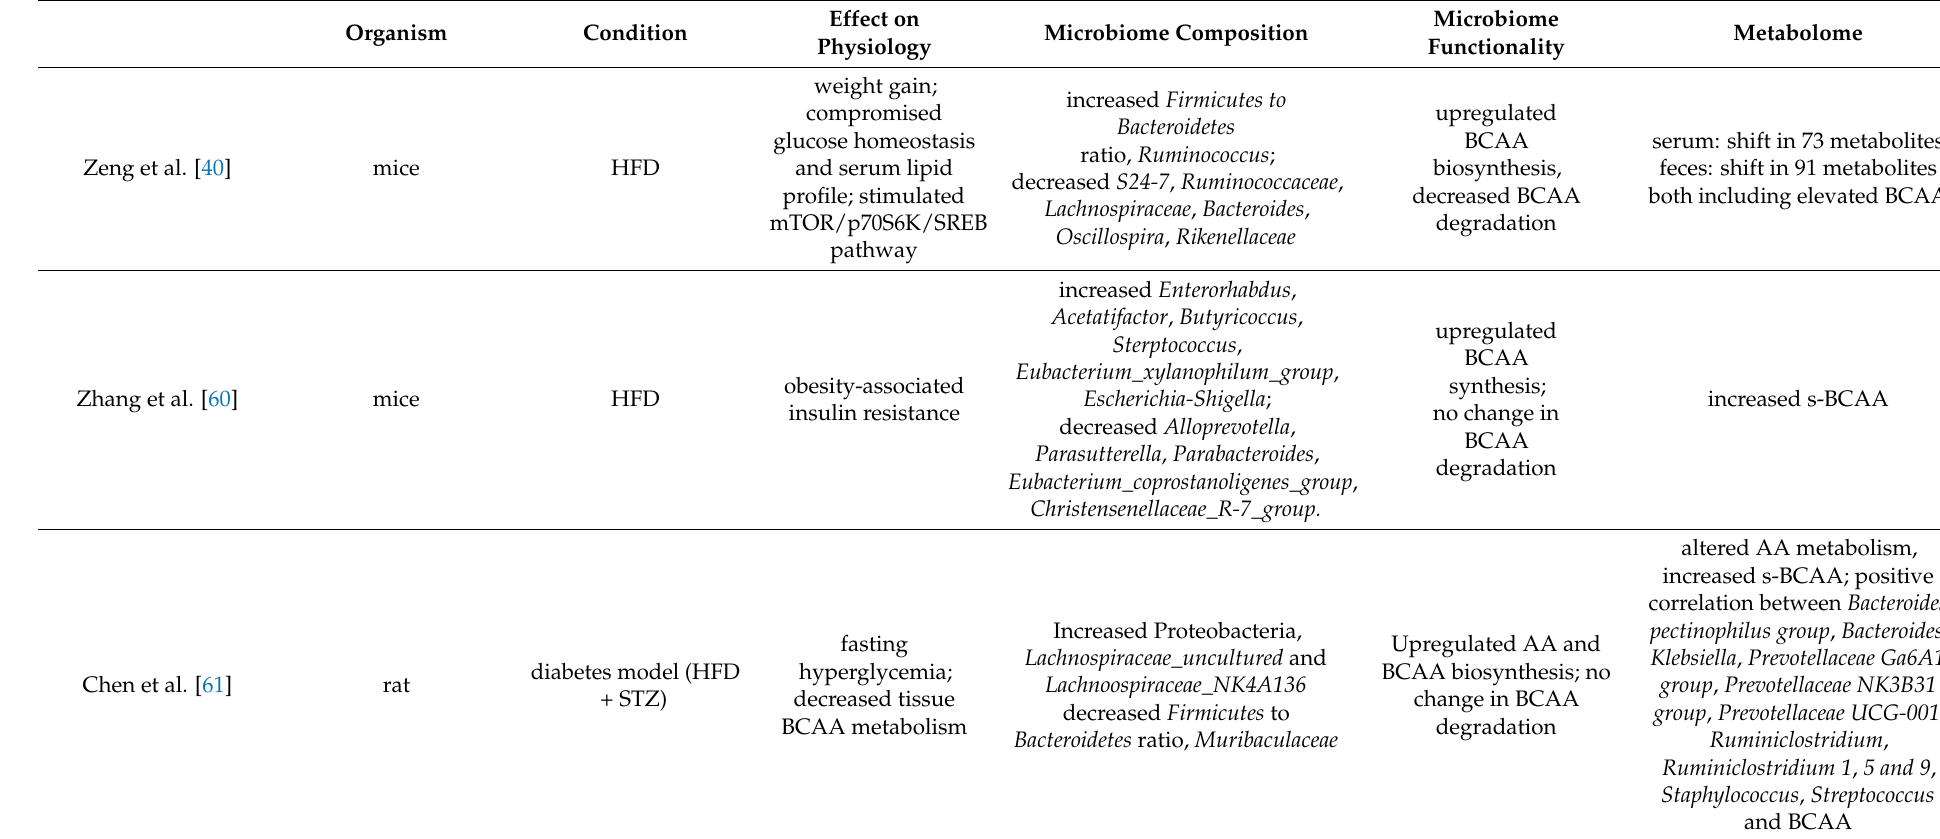
Table 2. Conditions associated with altered circulating BCAA concentration: animal